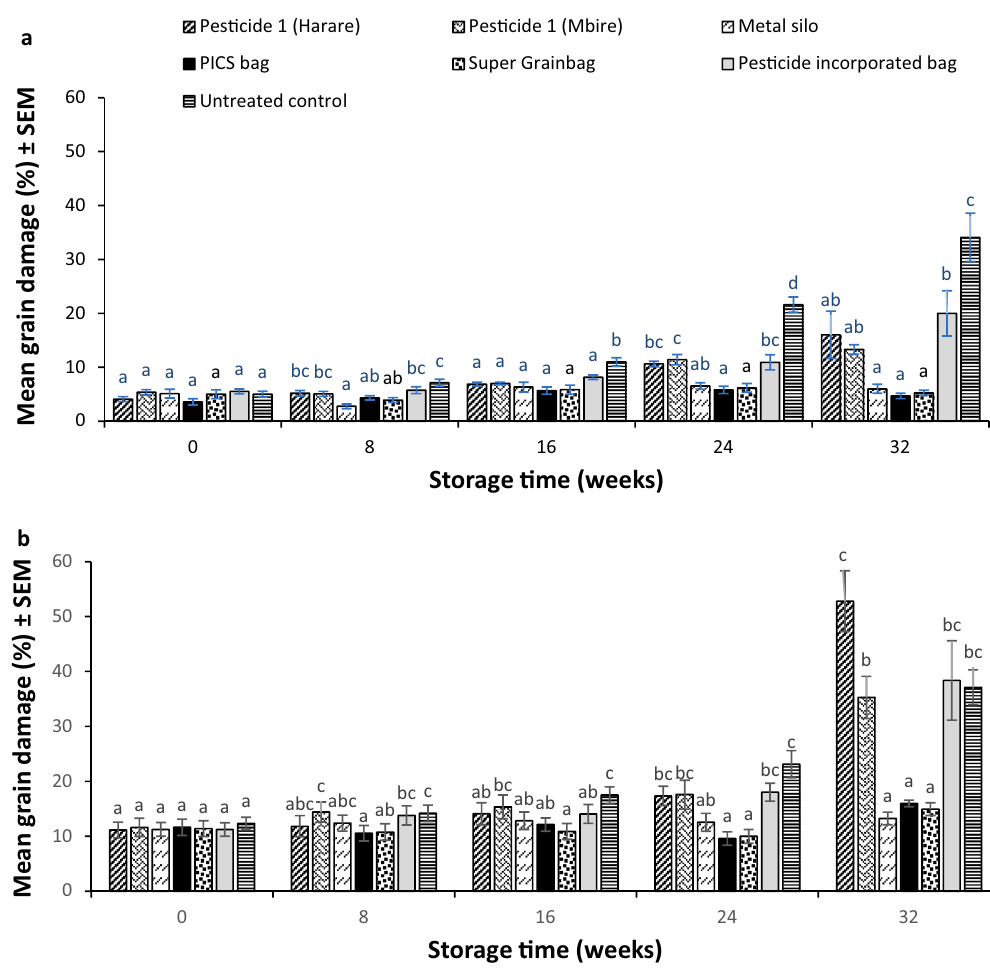
Figure 2. The effect of different grain storage treatments on sorghum grain insect damage (% ± SEM) during: (a) the 2014/15, and (b) the 2015/16 storage seasons in Mbire district, Zimbabwe (n = 8). Pesticide 1 = fenitrothion 1% + deltamethrin 0.13%; Pesticide 2 = pirimiphos-methyl 0.16% + thiamethoxam 0.036%; Pesticide-incorporated bag = deltamethrin-incorporated polypropylene bag at 3 mg/kg. Means were compared and separated at each sampling period (storage time) using Tukey’s test at 0.05 level.